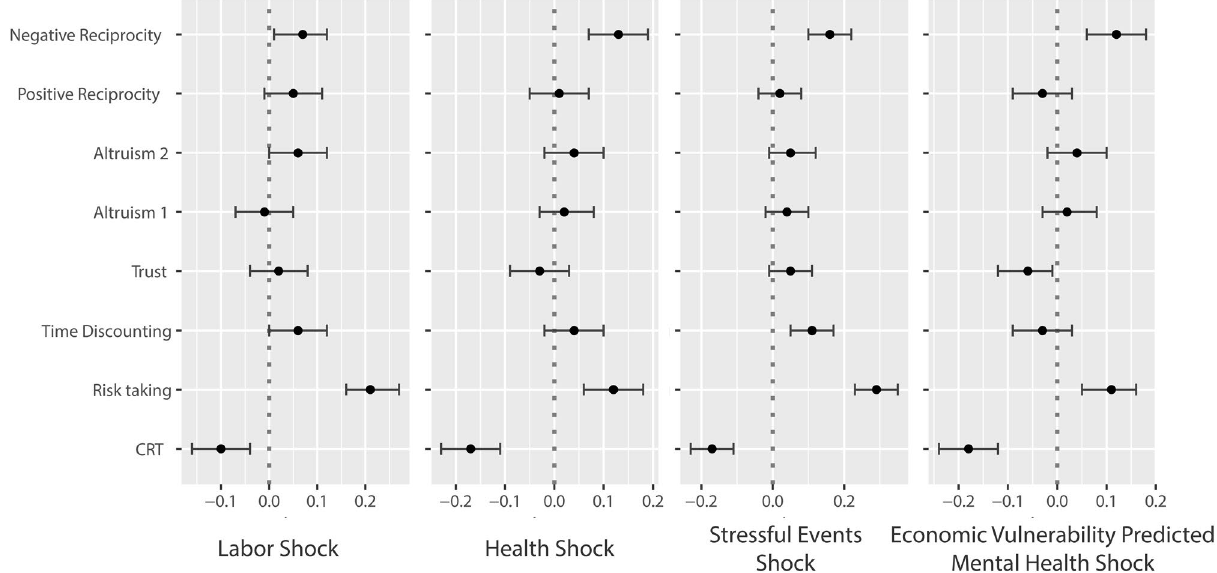
Figure 1. Estimated effect size for the outcome variables and the four measures of shocks (confidence interval at 95%). Note. Source: longitudinal multi-country survey conducted in Italy (N = 1,652), Spain (N = 1,660) and the United Kingdom (N = 1,578). OLS Regressions with Romano-Wolff confidence interval. Outcomes: CRT is the three items Cognitive Reflection Test. Risk Taking measures how much the participant is willing to take risks; Time discounting the willingness to give up something today in order to benefit from that in the future; Trust is the propensity to assume that people have only the best intentions; Altruism 1 is the share of a windfall endowment that the participant would be ready to share; Altruism 2 is participant’s willingness to share with others without expecting anything in return; Positive reciprocity is the choice (among six options) of a thank- you gift; Negative reciprocity is the willing to punish unfair behavior even if this is